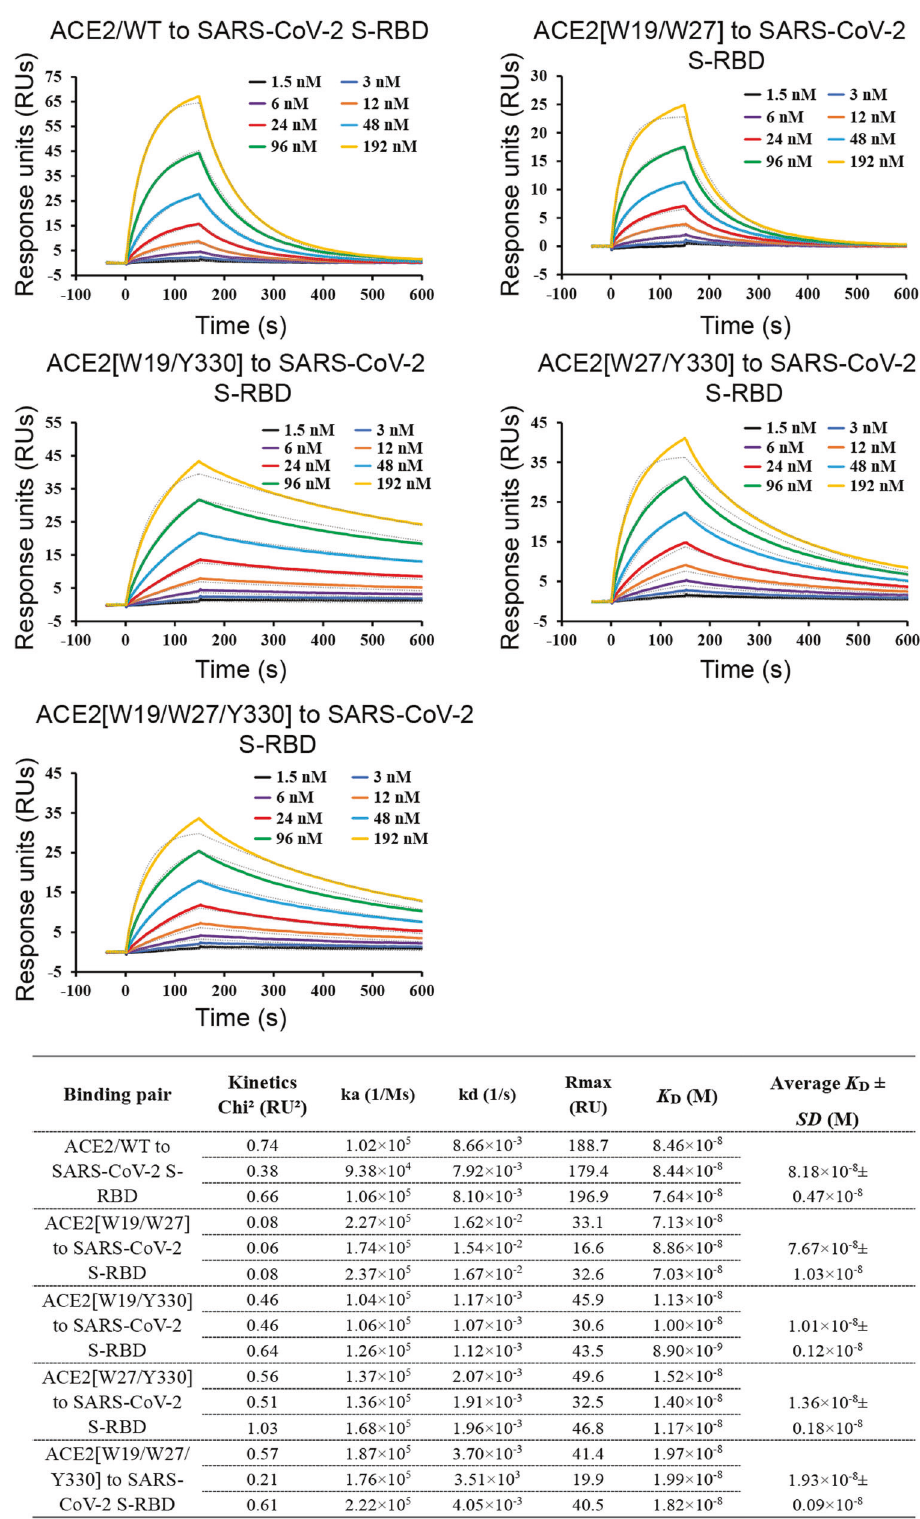
Fig. 1 An SPR assay characterizing the real-time binding kinetics of the ACE2 proteins (wild-type and mutants) to SARS-CoV-2 S-RBD. Three independent experiments are conducted and the recorded pro fi les from one representative experiment are shown. The slow-on/slow-off kinetic data are analyzed by the 1:1 binding model. The calculated kinetic parameters are summarized. ACE2/WT: wild-type ACE2; ACE2[W19/ W27]: ACE2 containing the S19W, T27W, H374A, H378A, and E402A mutations; ACE2[W19/Y330]: ACE2 containing the S19W, N330Y, H374A, H378A, and E402A mutations; ACE2[W27/Y330]: ACE2 containing the T27W, N330Y, H374A, H378A, and E402A mutations; ACE2[W19/W27/ Y330]: ACE2 containing the S19W, T27W, N330Y, H374A, H378A, and E402A mutations